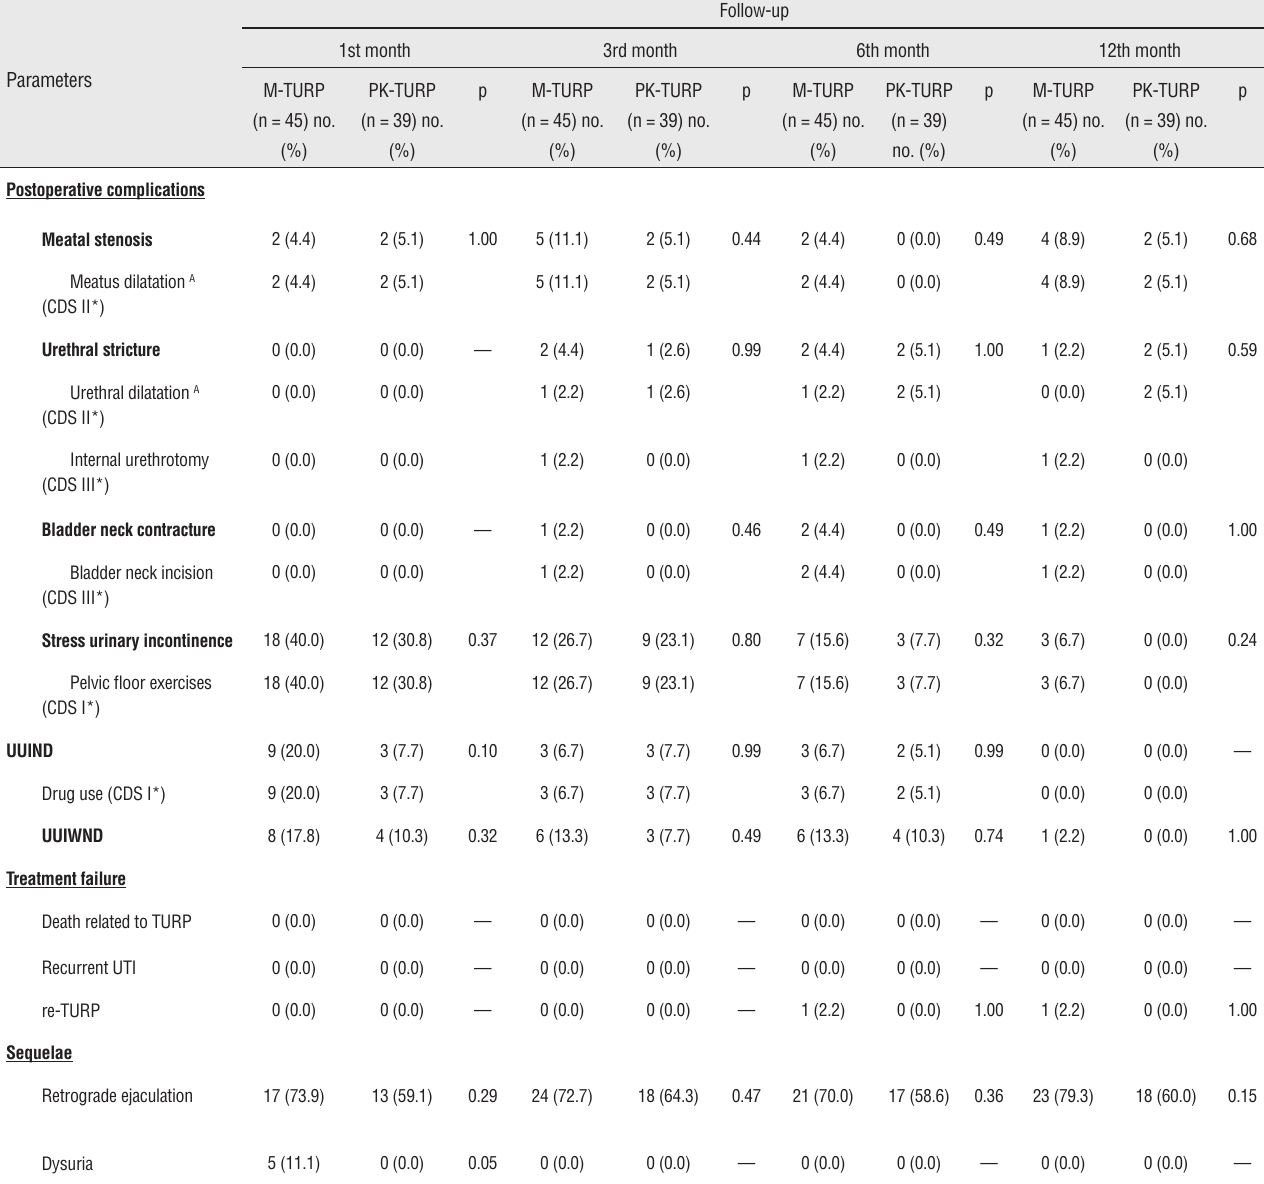
Table 4 - Postoperative complications and sequelae stratified by treatment.